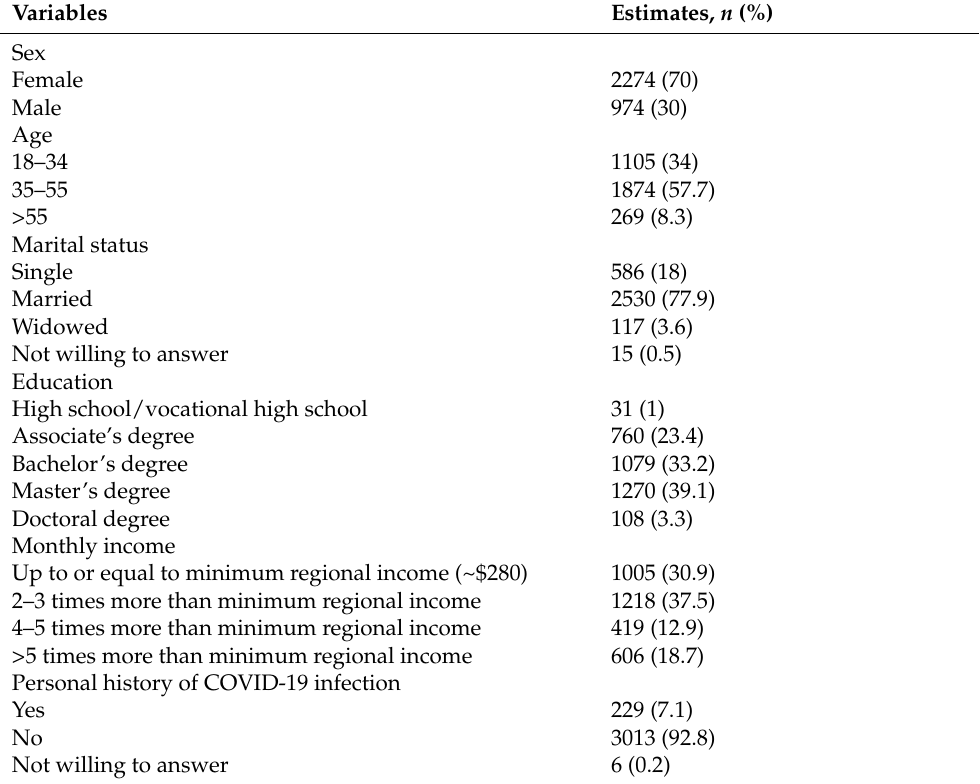
Table 1. Respondent characteristics ( n =